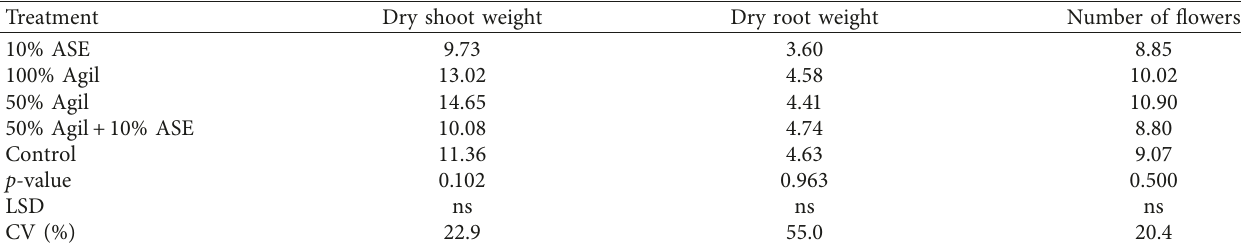
Table 5: Effect of postemergence sorghum aqueous extracts and Agil treatments on the dry shoot weight, dry root weight, and number of flowers of black